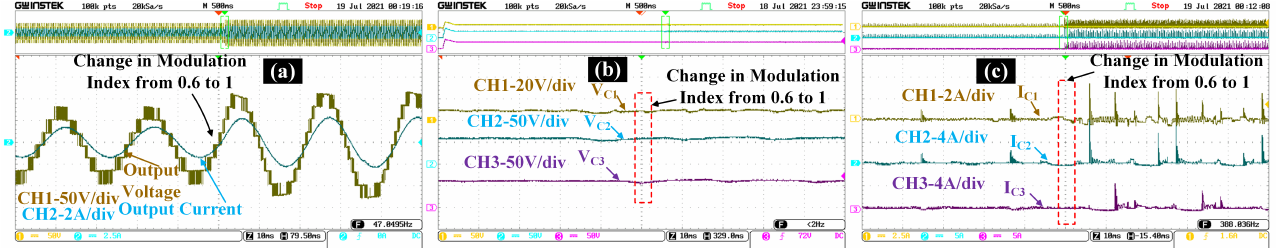
Figure 10. Experimental Results for load 50 Ω , 20 mH when modulation index changes from 0.6 to 1 at fixed V in = 30 V. ( a ) Output voltage and Output current, ( b ) Voltage across capacitor ( V C 1 , V C 2 ,